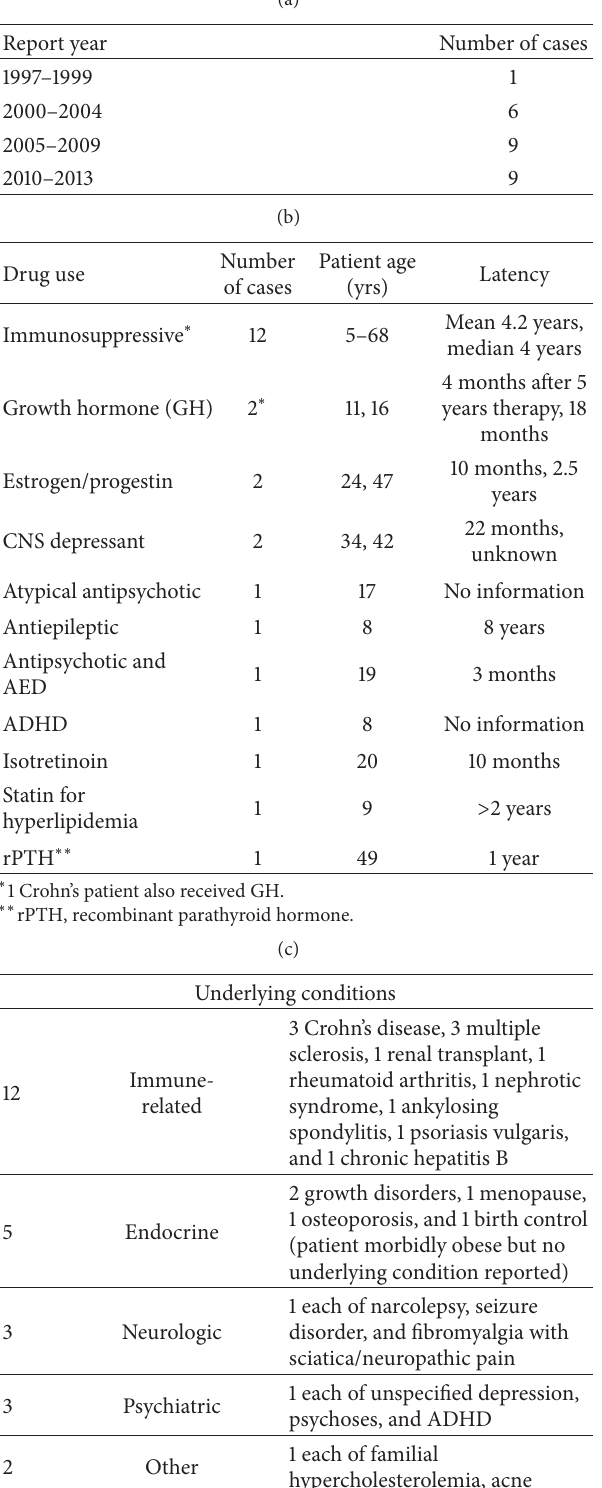
Table 1: Summary of FAERS reports of medication use prior to Ewing Sarcoma Family of Tumor (ESFT) diagnosis, 1997–2013. Total = 25; 13 US, 12 foreign; 16 females, 9 males. Ages 4–68 years